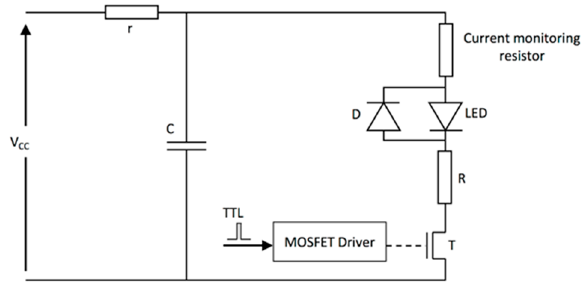
Figure 5. Schematic of a typical LED driver for the pulse operation mode. Vcc is the voltage provided by the power supply, T is the transistor used to switch the LED on and off, C is the storage capacitor, R is the limiting resistor, r is the charging resistor, D is a diode, and MOSFET is a metal oxide semiconductor field-effect transistor. Reprinted with permission from High-Power Light Emitting